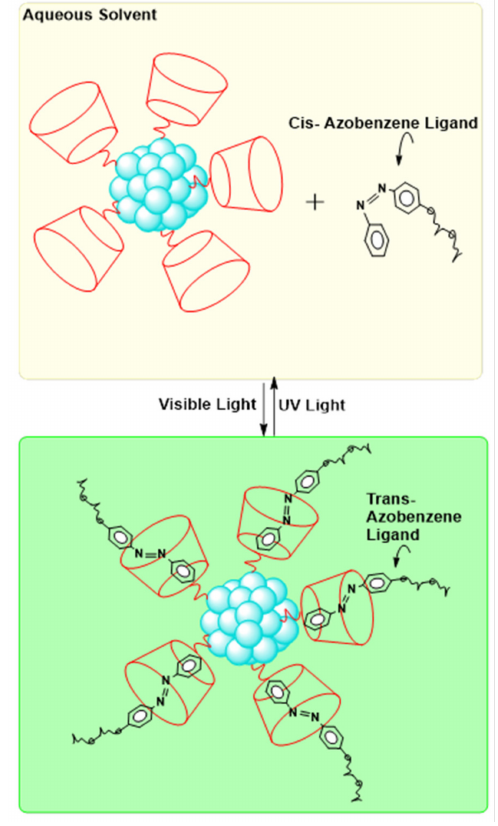
Figure 6. Schematic representation of phase transfer via host–guest chemistry. Scheme derived from [35].